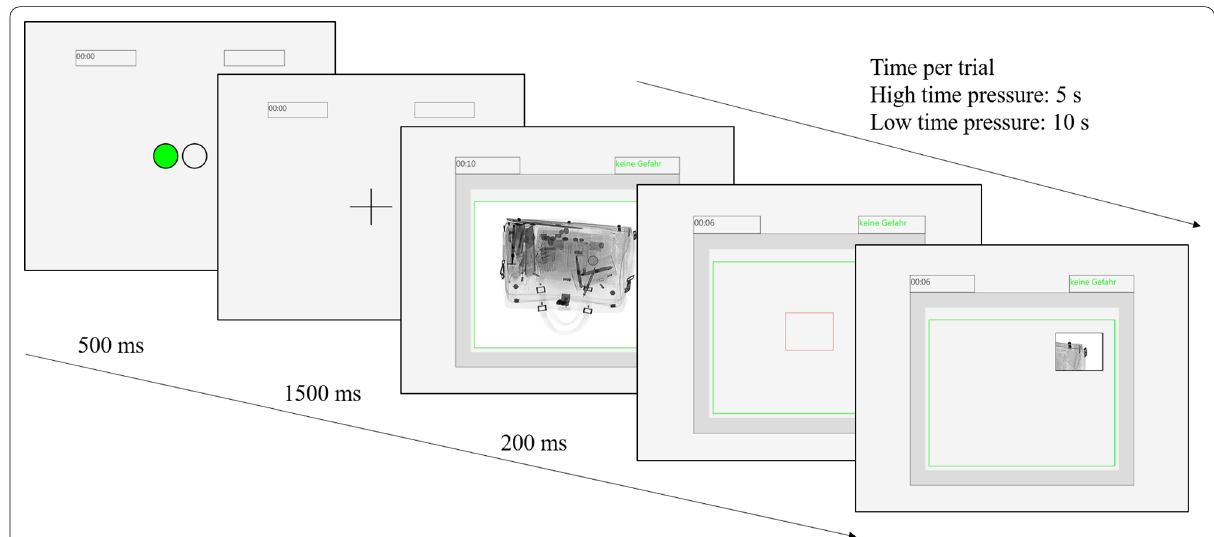
Fig. 1 Typical trial procedure in the automation condition. Note that in the manual blocks, the fixation cross was presented for 2000 ms with no automation cue at trial